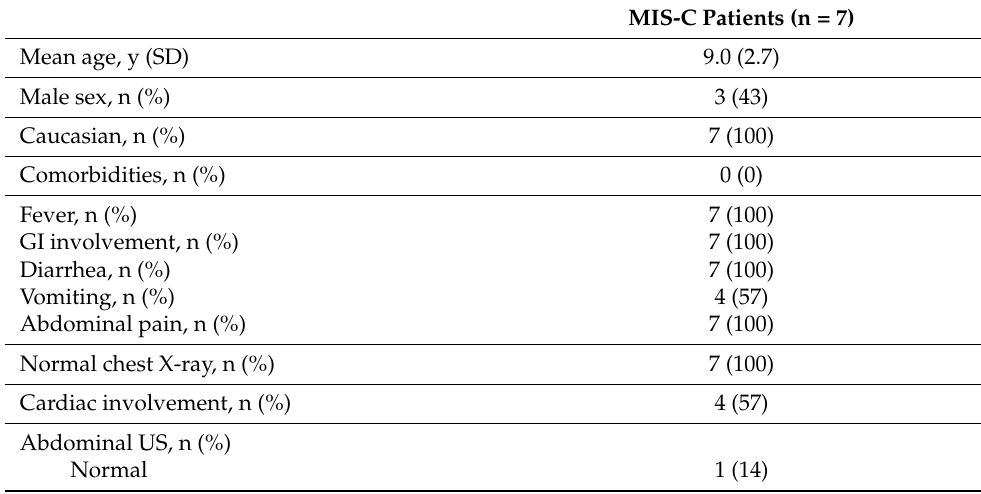
Table 5. Features of children with